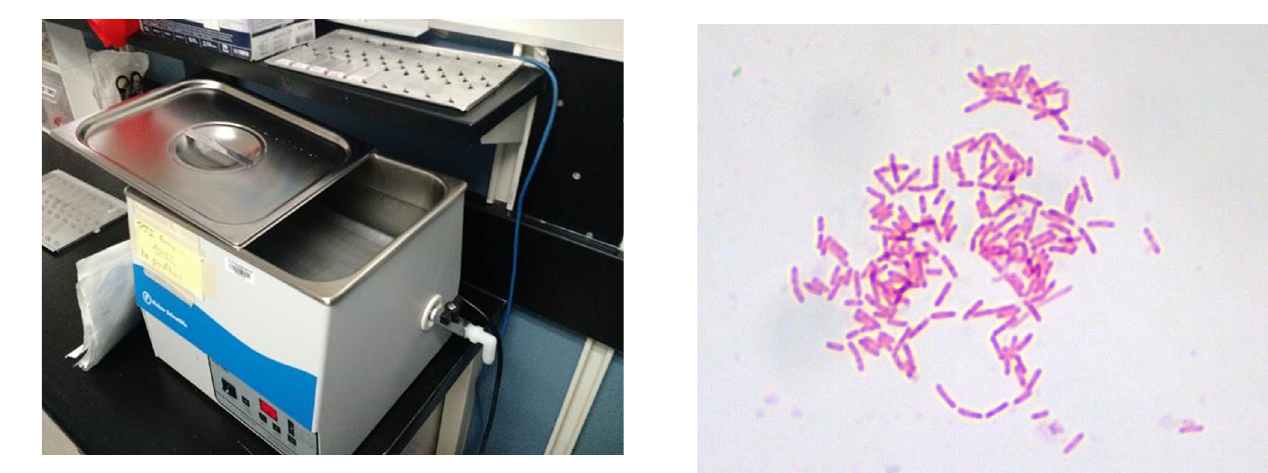
Figure 1. Ultrasonicator device used to disrupt bacterial biofilm on prosthetic and implant devices. The prosthetic device is placed in a container filled with saline and then placed in this waterbath where ultrasound waves are directed at it. Figure 2. Gram stain of Ralstonia pickettii under light